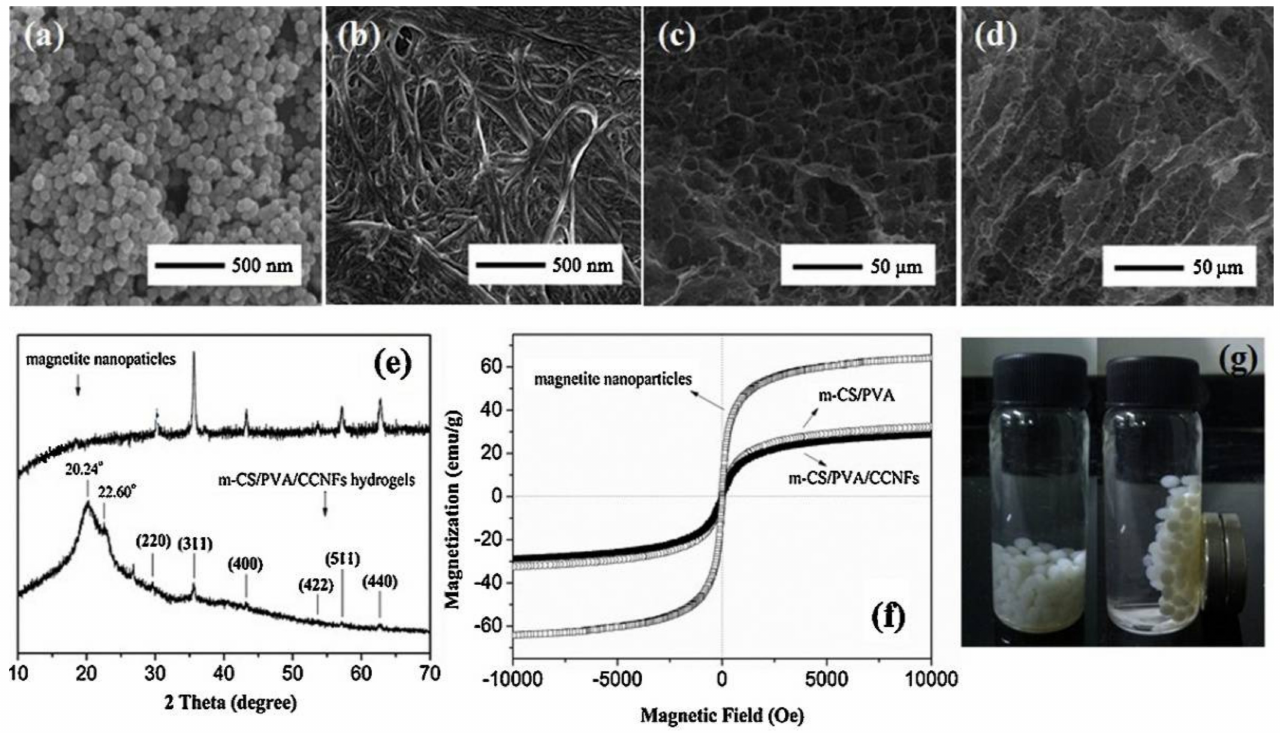
Figure 8. SEM images of magnetite nanoparticles ( a ), CCNFs ( b ), m-CS/PVA hydrogels ( c ), and m-CS/PVA/CCNFs hydrogels ( d ), XRD patterns of magnetite nanoparticles and m-CS/PVA/CCNFs hydrogels ( e ), magnetization curves of magnetite nanoparticles and hydrogels at room temperature ( f ) and photographs of m-CS/PVA/CCNFs hydrogels in Pb(II) solution before and after magnetic separation by an external magnetic field ( g ). Reprinted from